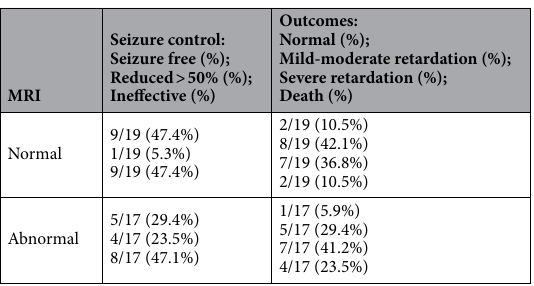
Table 4. The table of MRI and prognosis. MRI, Magnetic resonance